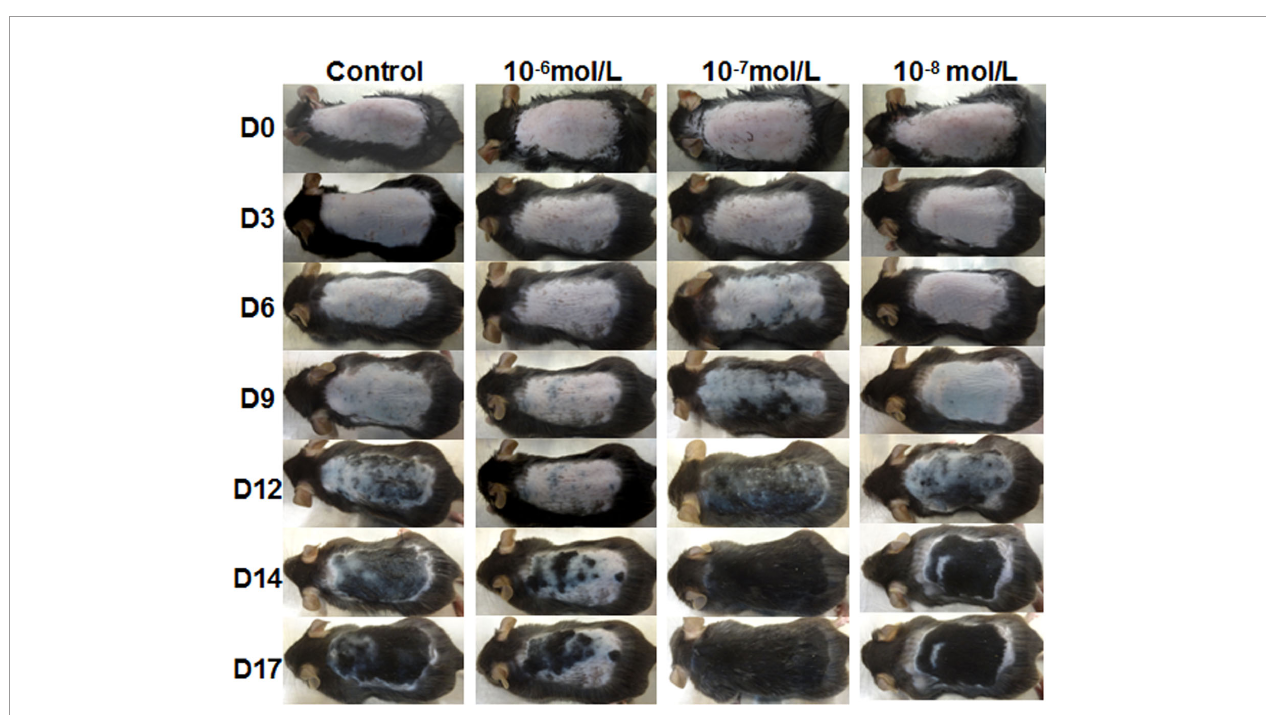
FIGURE 2 | Effects of topical dihydrotestosterone (DHT) on hair regeneration in C57BL/6 mice. The back skin was treated with DHT (10 -6 , 10 -7 , or 10 -8 mol/L) every day for 18 days in the DHT groups, while the vehicle-treated control group was treated with 40% DMSO. The back skin was photographed at days 0, 3, 6, 9, 12, 14, and 17 after treatment